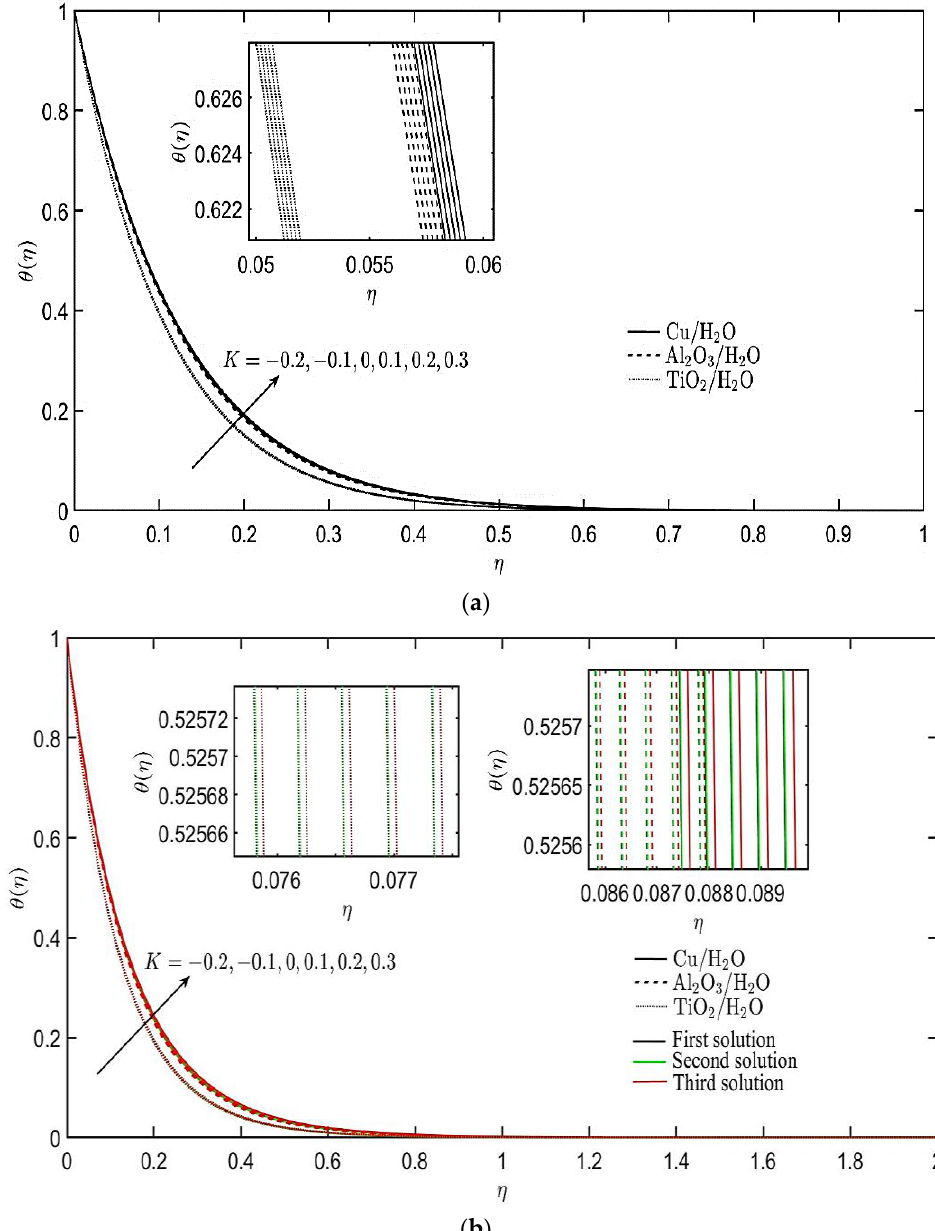
Figure 6. Effect of heat source/sink parameter on temperature profiles for: ( a ) Stretching case; ( b ) Shrinking case.